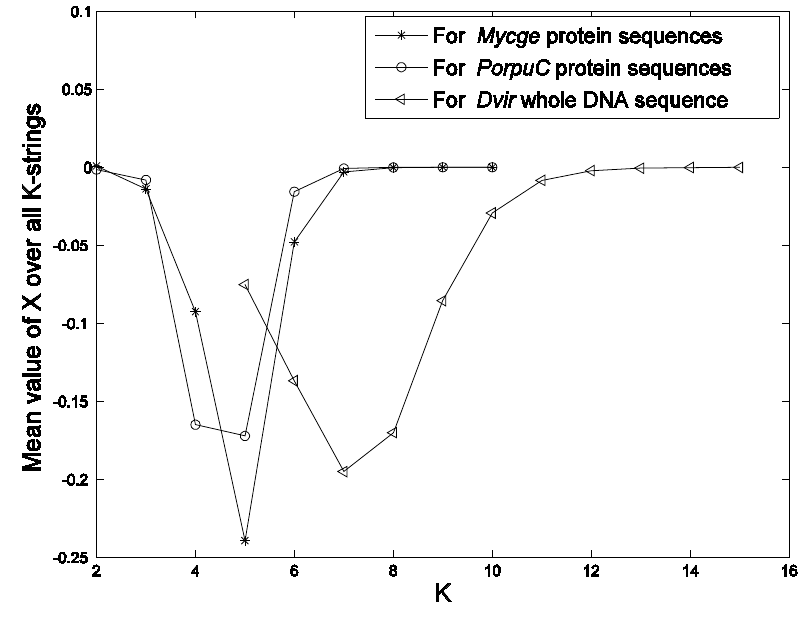
Figure 1. The plot of mean value of X over all K -strings as a function of K .